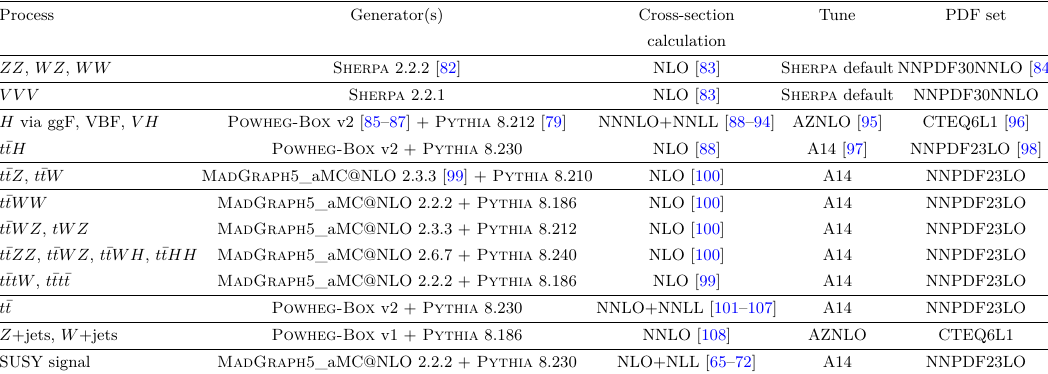
Table 3. Summary of the simulated SM background and signal samples used in this analysis, where V = W, Z , and includes off-shell contributions. “Tune” refers to the set of parameter values used by the